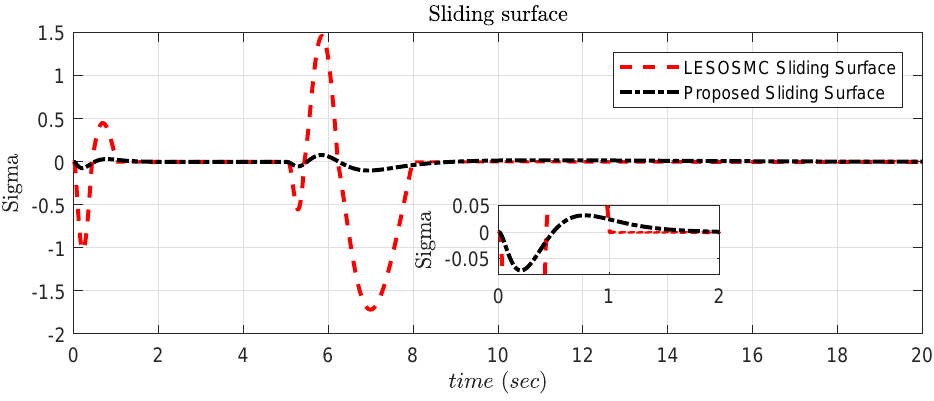
Figure 6. Sliding surface response for Example